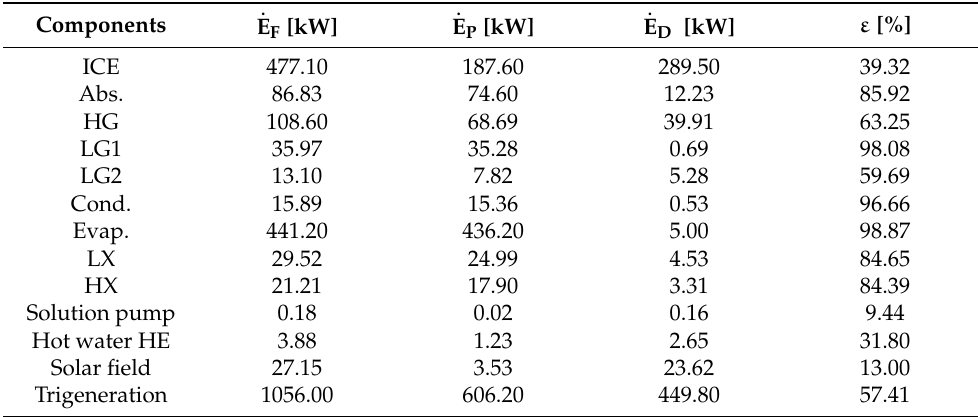
Table 4. Results of exergy analysis considering dead state temperature of 10 ◦